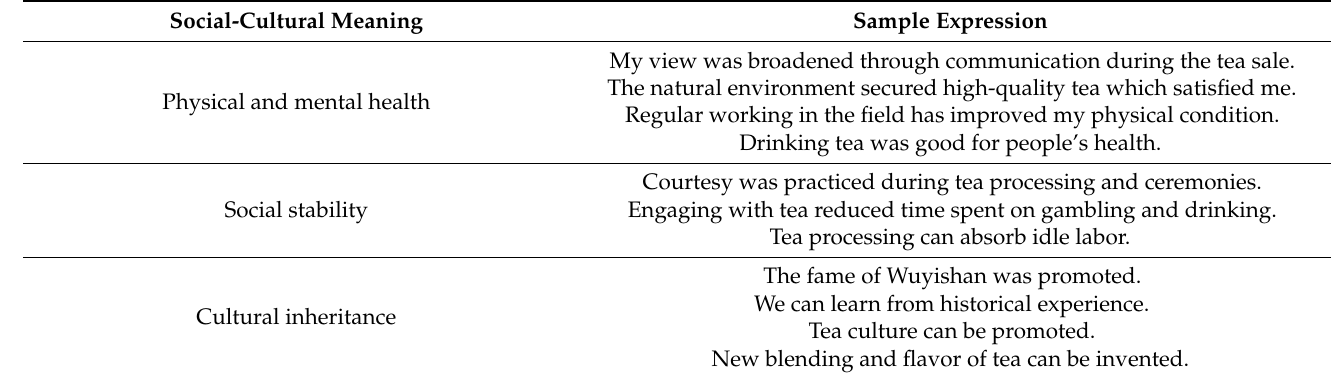
Table 3. Socio-cultural benefits expressed by the